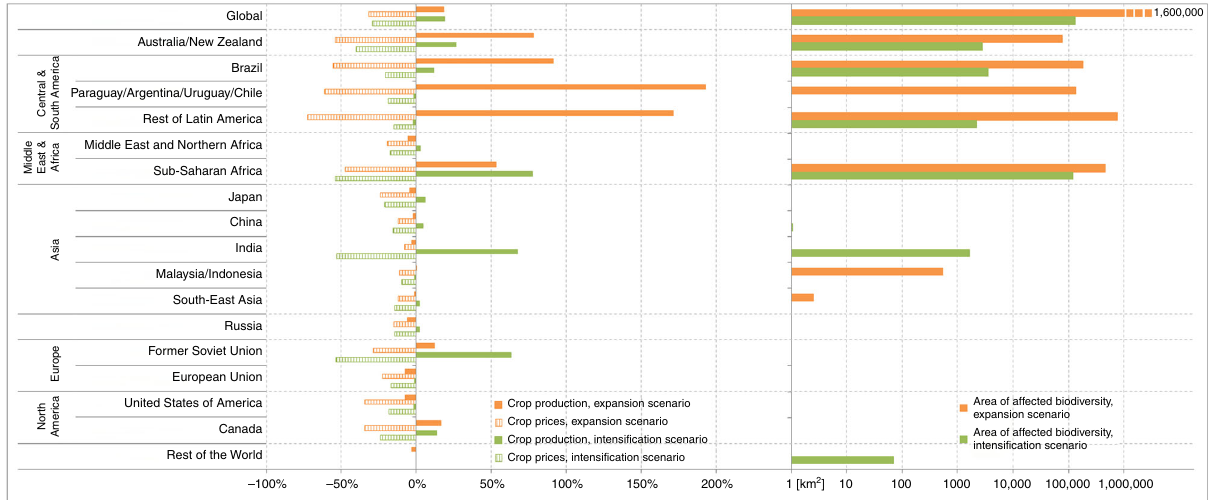
Fig. 2 Impacts of expansion and intensi fi cation on production, prices and area of affected biodiversity. The left panel shows the change in crop production and prices under expansion and intensi fi cation scenarios compared to the reference scenario in 2030, accounting for current trends in population growth, gross domestic product and trade policies. The right panel shows the area of land where the top 10% of the most biodiverse regions are threatened under the expansion and intensi fi cation scenario ( x -axis for area is scaled